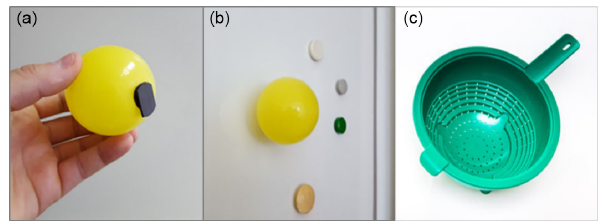
Figure 2. A piece of magnetic strip glued to a plastic ball (a) that represents a unit amount (1mm) of effective rainfall, as well as gen- erated specific runoff. It can be tacked to most of the classroom white/black boards (b) . The sieve is used to “collect” generated runoff during the routing procedure (c)